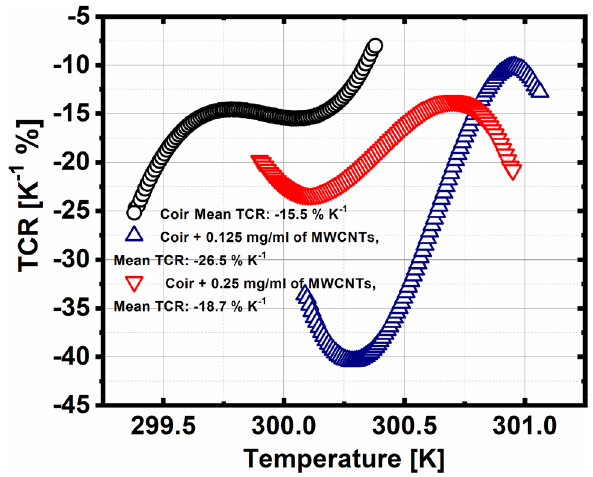
Figure 4. TCR as a function of temperature.